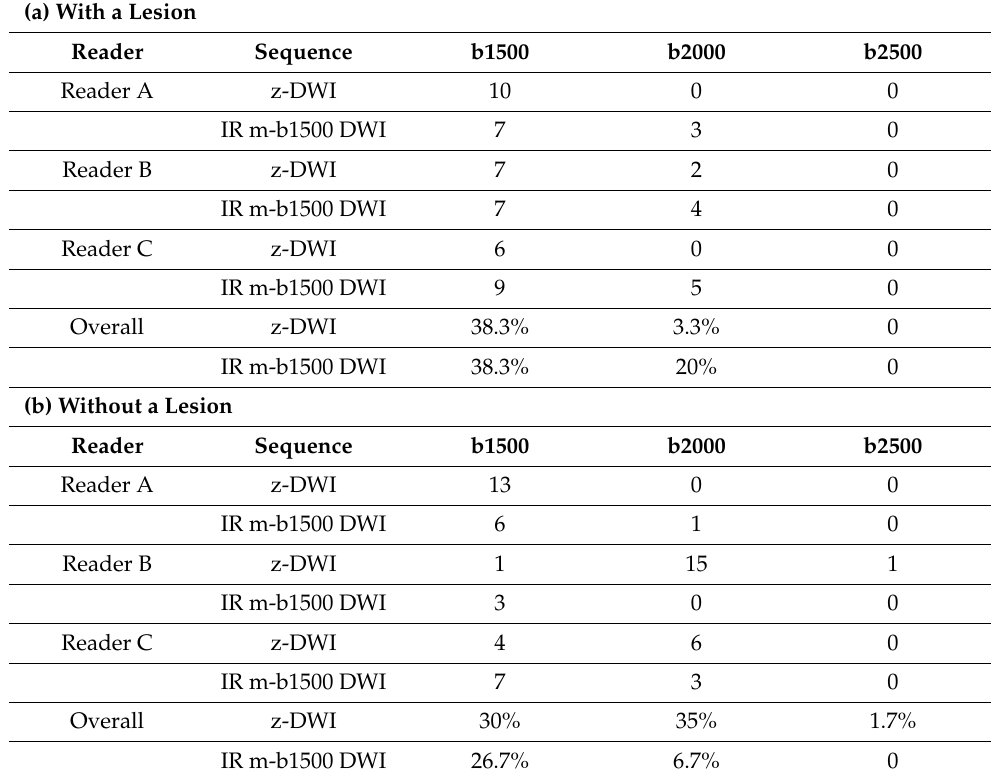
Table 3. Sequence and b-value preference (number of selections by each reader and the percentage of selections across all